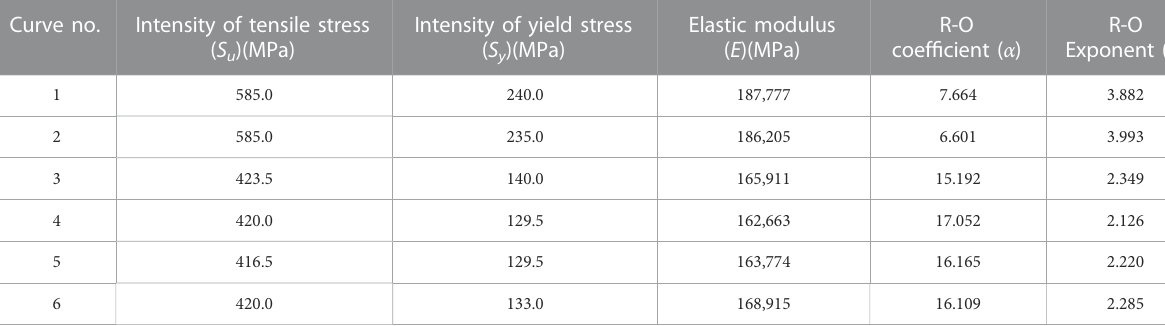
TABLE 2 Material properties. Curve no.